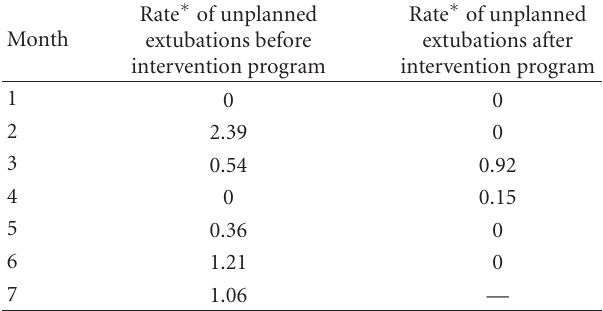
Table 3: Rate of unplanned extubations/100 ventilated days by study